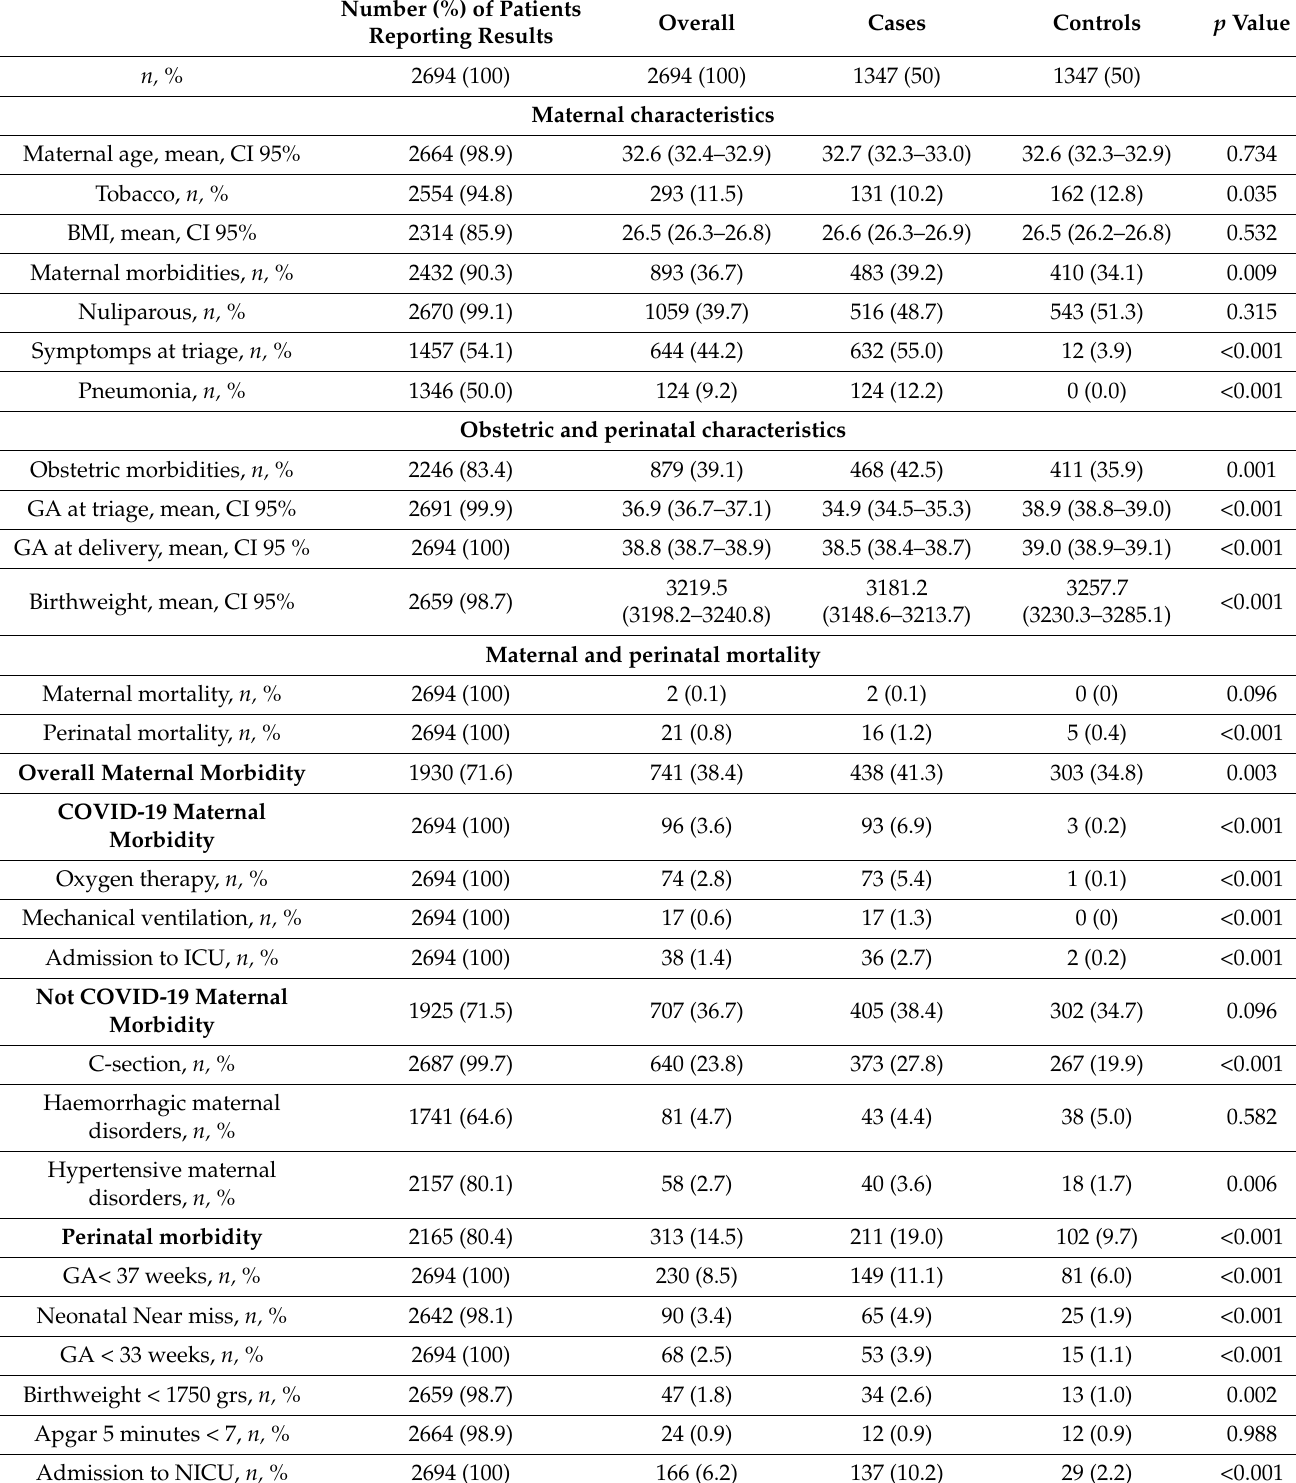
Table 1. Maternal